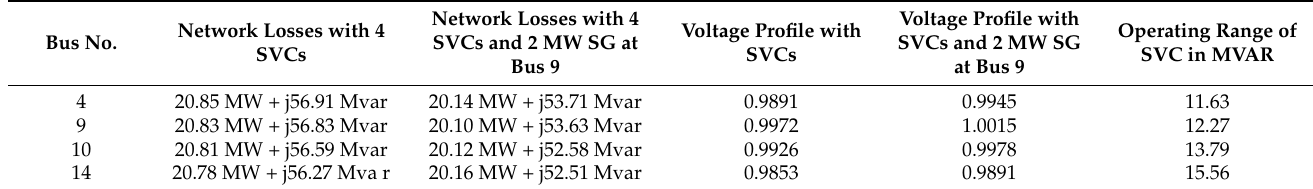
Table 7. Comparison of results with and without Solar Panels of 2